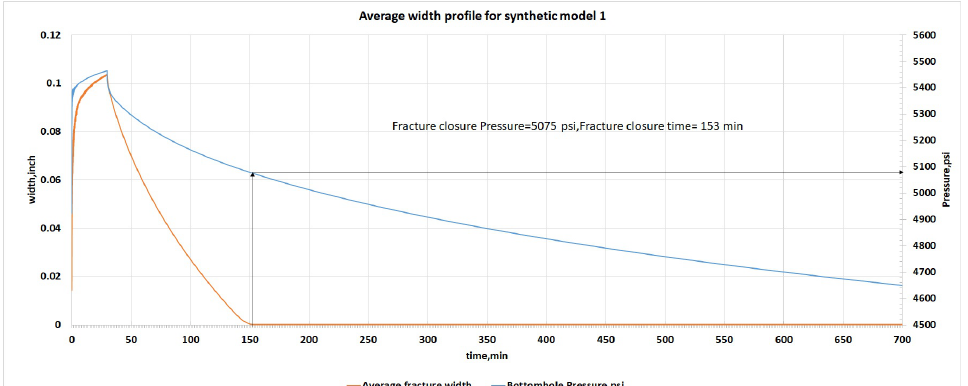
Figure 9. Average width profile for synthetic model